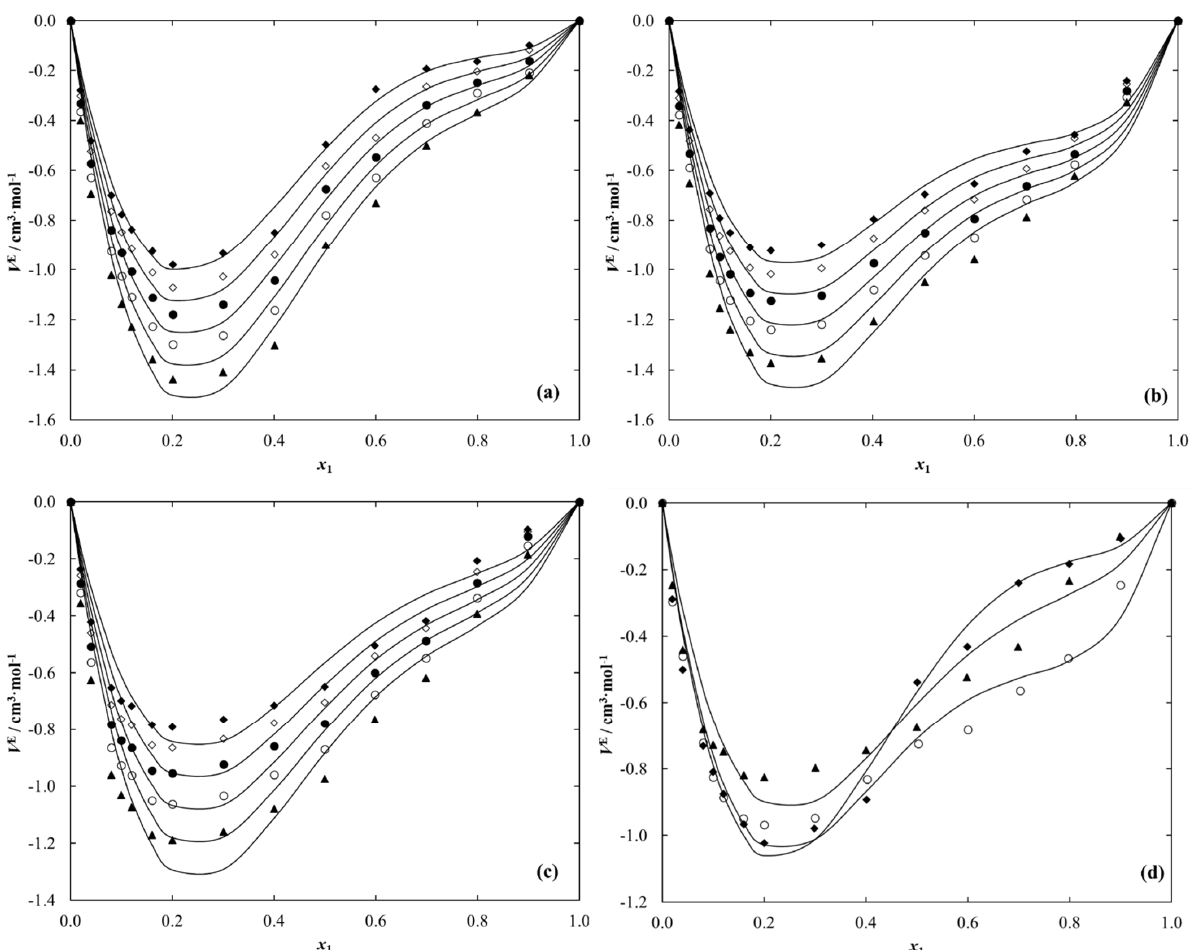
Figure 6. Excess molar volume, V E for {IL (1) + Ethanol (2)}: ( a ) [C 1 C 2 MOR][DMP]; ( b )